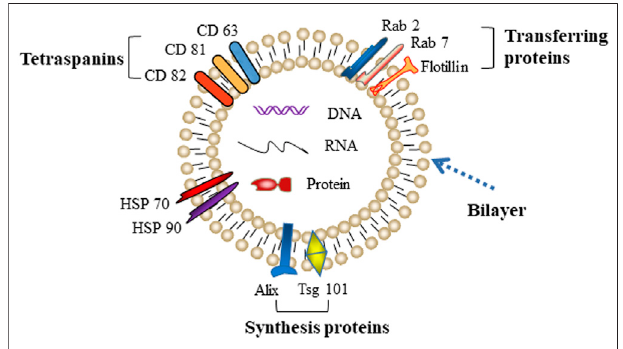
FIGURE 1 | Typical characteristic of